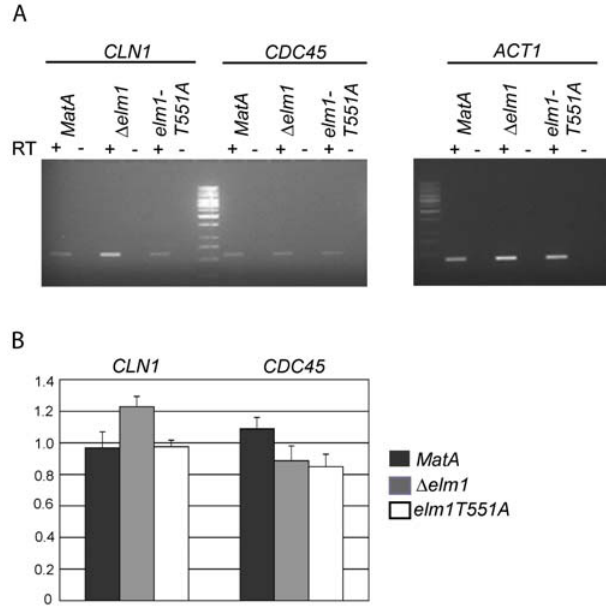
Figure 4. SBF activity is increased in the Elm1 deletion strain. (A) A representative result of semi-quantitative RT-PCR analysis of the SBF- specific gene, CLN1 , the MBF-specific gene, CDC45 and control gene, ACT1 in MatA , D elm1 and elm1T551A . RT=reverse transcriptase. (B) Average expression of CLN1 and CDC45 normalized to ACT1 expression, over three different experiments. Error bars represent standard